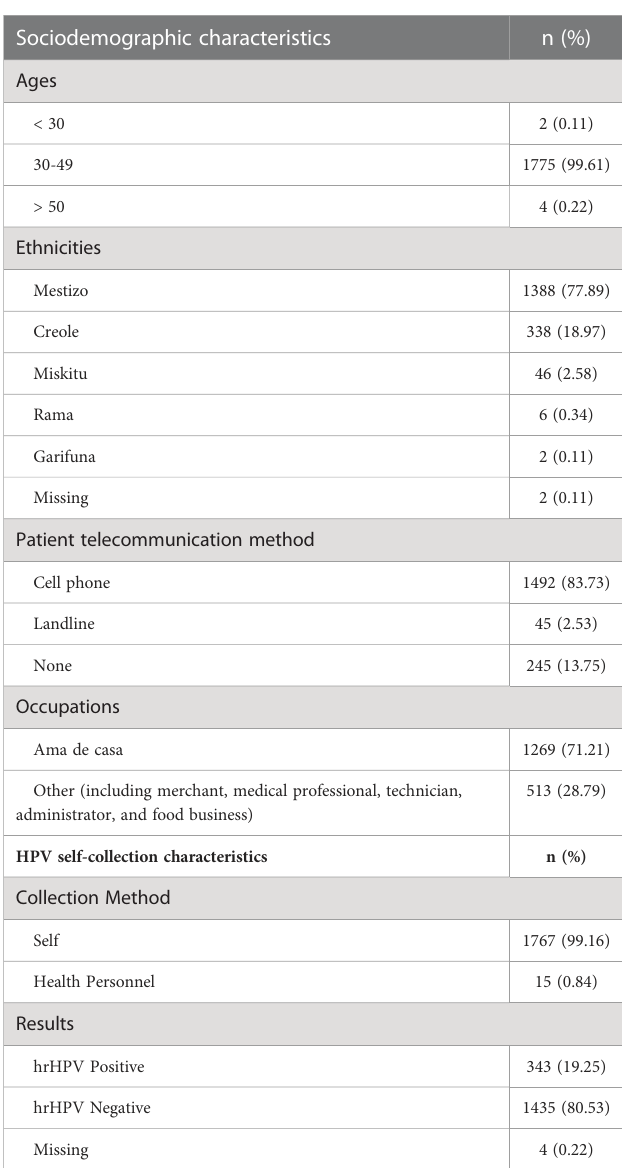
TABLE 2 Characteristics of study participants ( N=1782